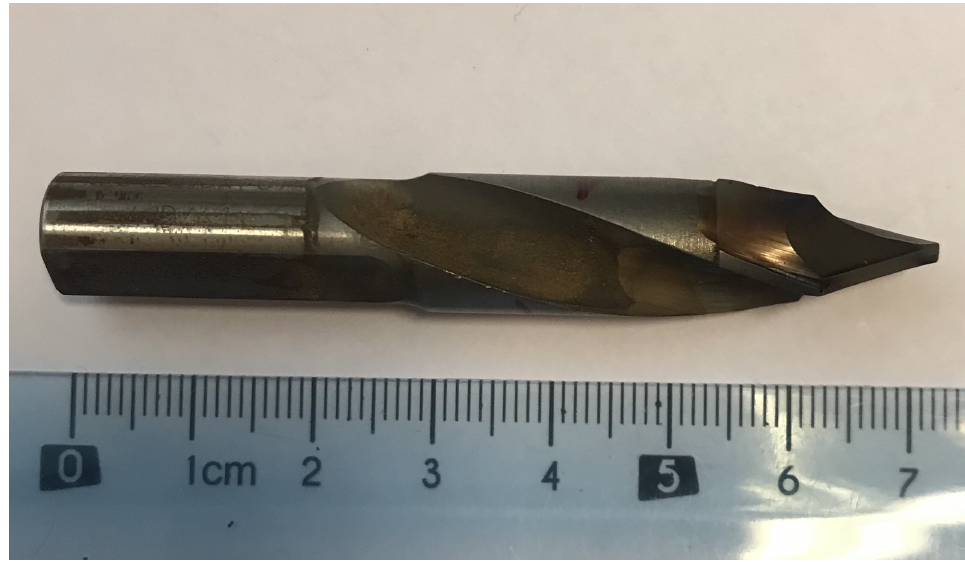
Figure 1. The FABA WP-01 drill used during